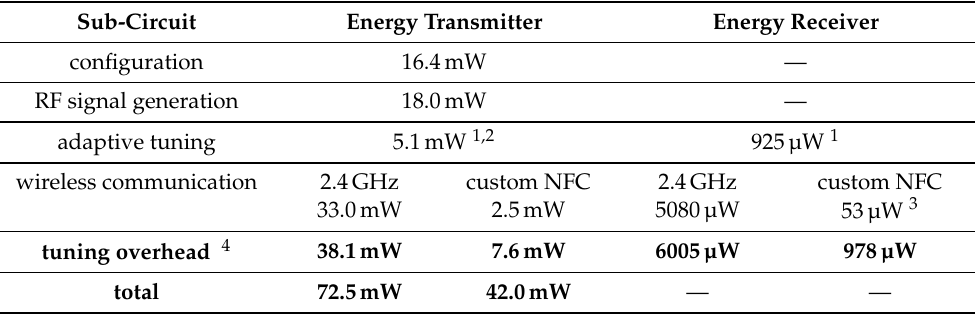
Table 4. Self-consumptions of the custom wireless power transfer circuits. Sub-Circuit Energy Transmitter Energy Receiver